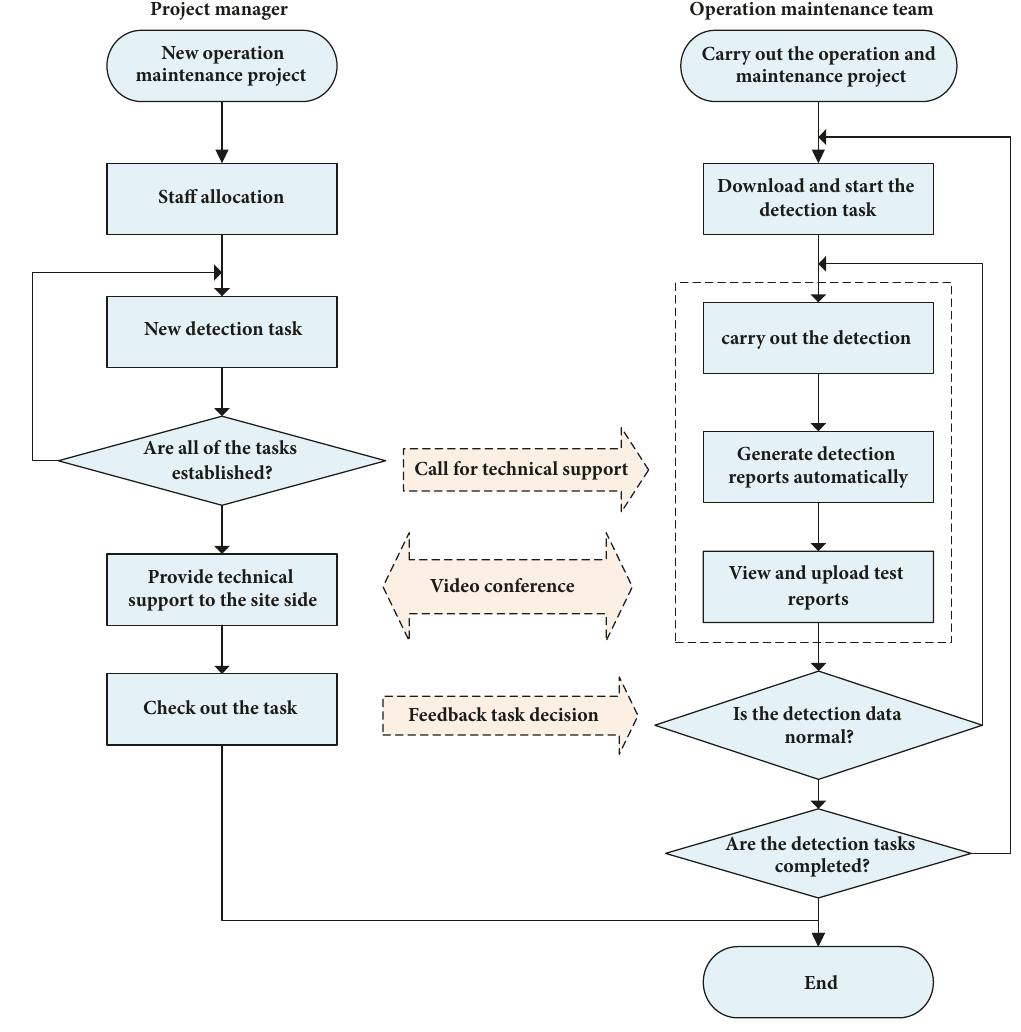
Figure 7: Workflow of OM